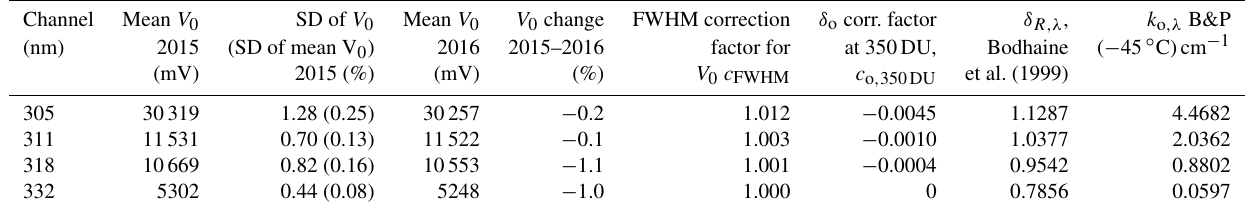
Figure 1. Results of all the Langley plot calibrations at IZO during May–August 2015. The final V 0 ’s are derived from linear interpolation at zero ozone change. The ozone change during each Langley event is calculated from a linear fit of the Brewer triad total ozone values versus ozone air mass during the Langley event. Table 2. Langley calibration results for UVPFR no. 1001 at Izaña 2015 and 2016, together with calculated V 0 and δ o FWHM correction factors. Also the used Rayleigh optical depth and ozone absorption coefficients used for the UVPFR no. 1001 are